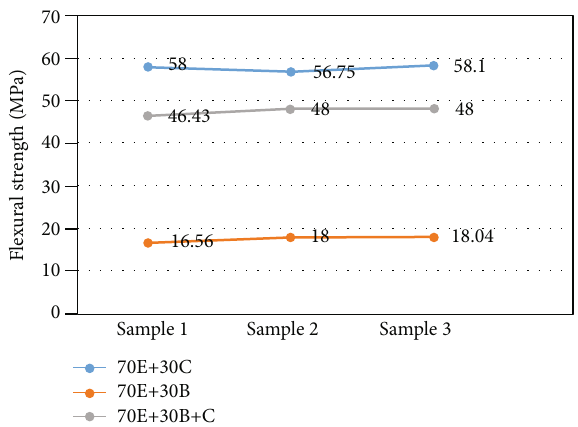
Figure 5: Samples testing for fl exural testing.